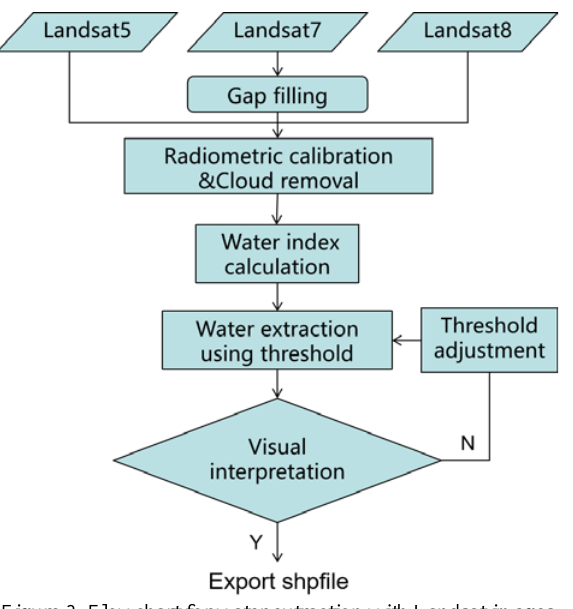
Figure 4. Extraction of Yarlung Zangbo River reach